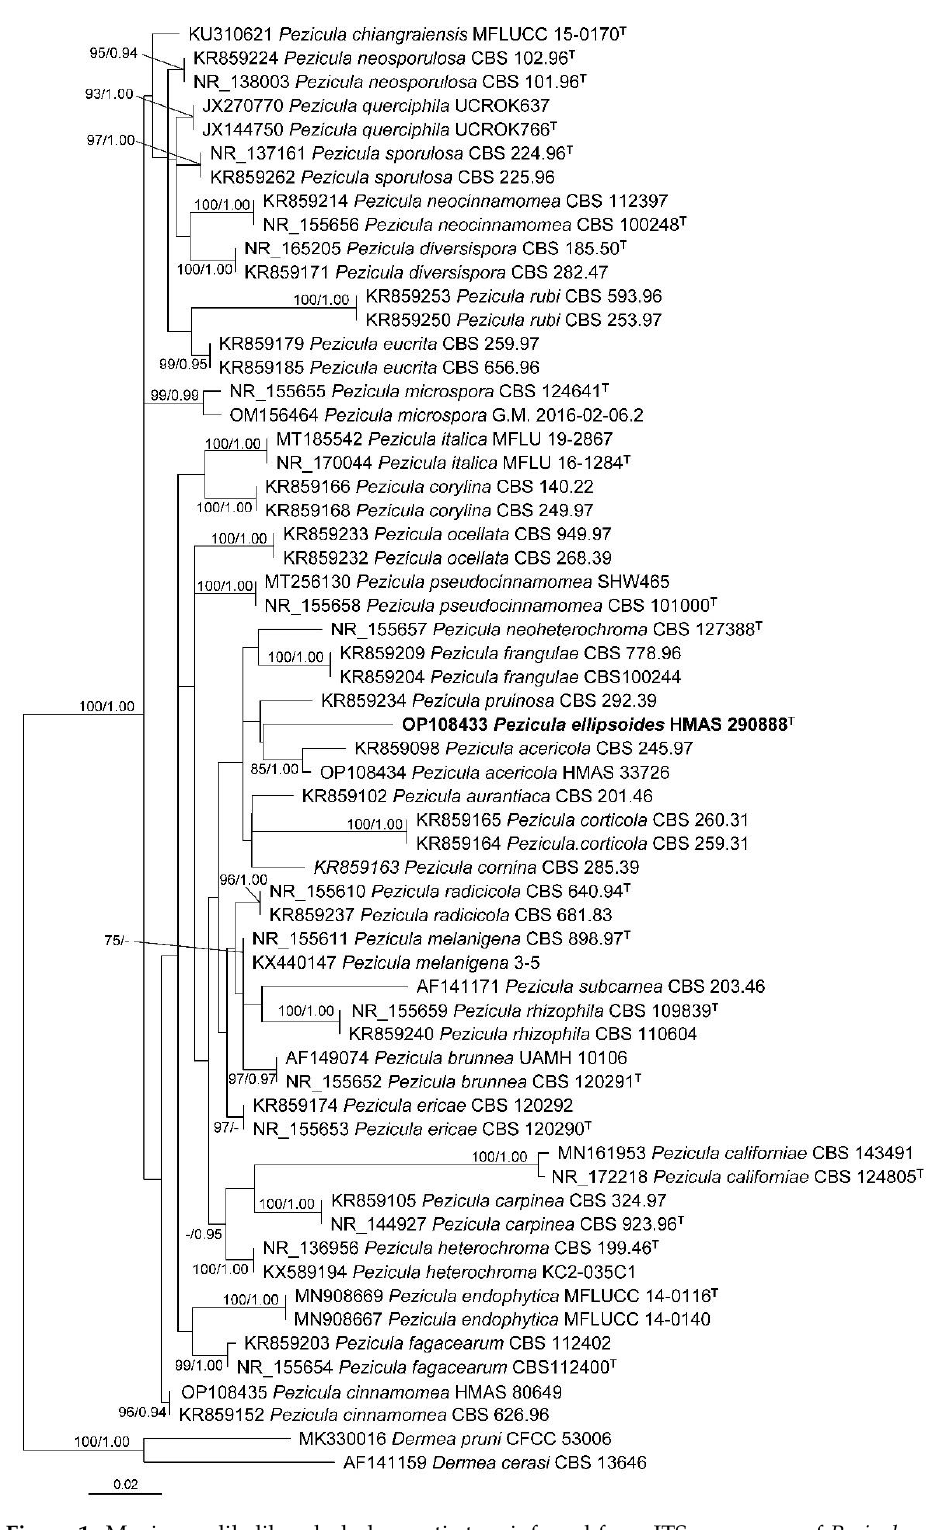
Figure 1. Maximum likelihood phylogenetic tree inferred from ITS sequences of Pezicula species. Dermea cerasi and D. pruni were used as outgroup taxa. Types are indicated with the superscript letter “T”. The new species proposed in the present study is in bold. Bootstrap support values ≥50% and Bayesian posterior probabilities ≥0.90 are shown at the nodes. The scale bar represents the number of nucleotide substitutions per site.